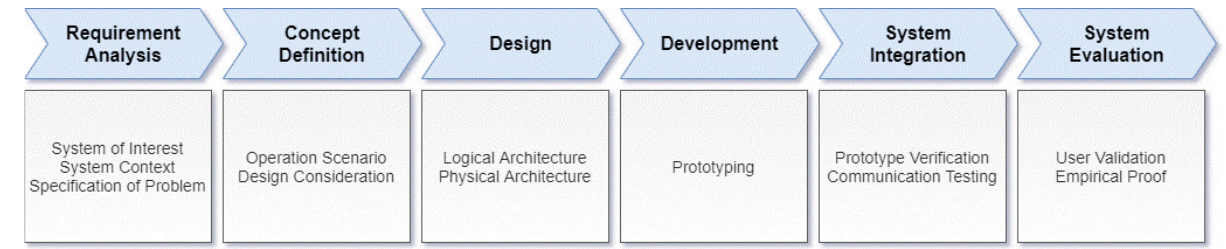
Figure 1. Schematic diagram of the system development